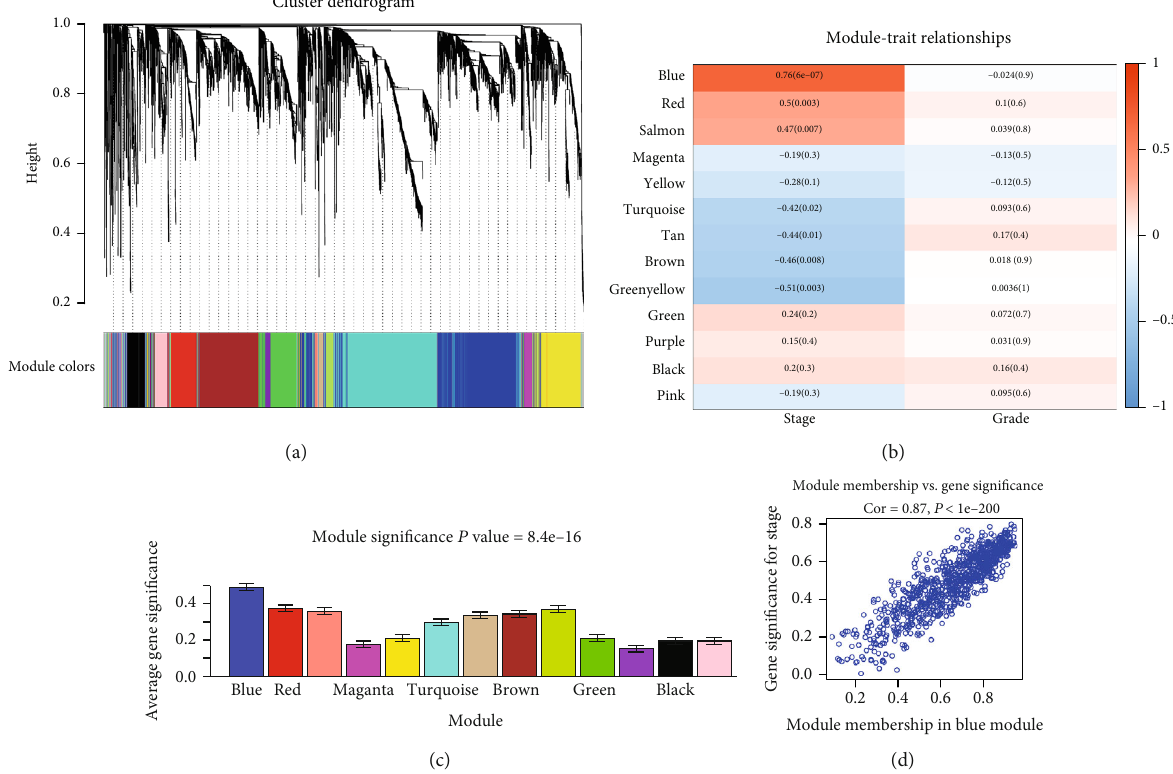
Figure 4: Identi fi cation of relevant modules of pancreatic cancer clinical traits. (a) Clustering dendrograms of genes based on dissimilarity topological overlap and module colours. (b) Heatmap of the correlation between module eigengenes and clinical traits of pancreatic cancer. (c) Distribution of average gene signi fi cance in the modules connected with the clinicopathological stages of pancreatic cancer. (d) Scatter plot of module eigengenes in the blue